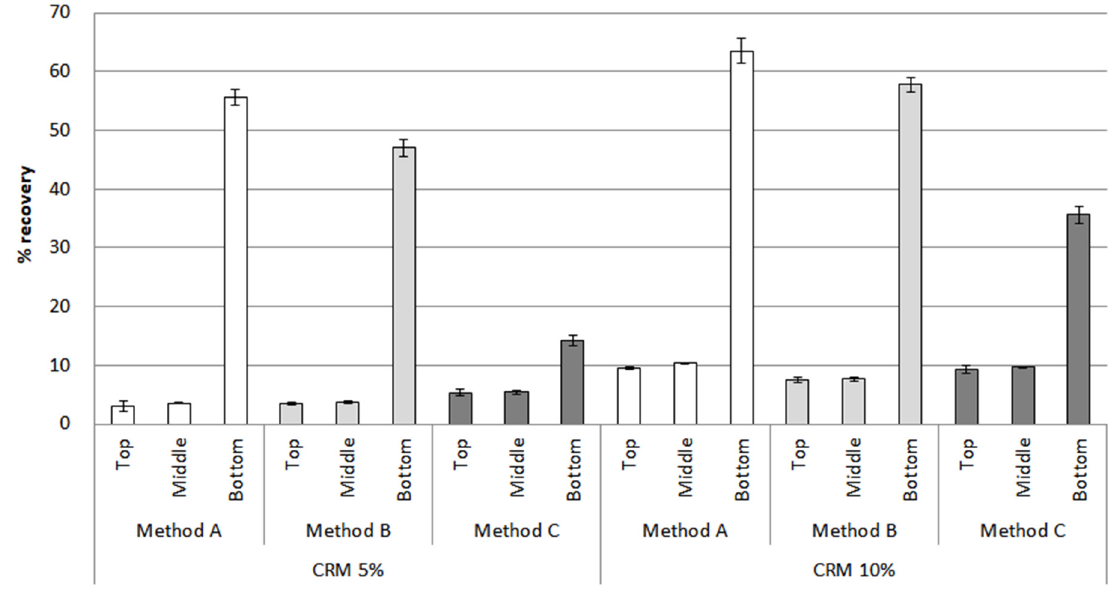
Figure 13. The percentage recovery (0.1 kPa) of the CRM asphalt binders for each mixing method in the top, middle, and bottom parts, after conditioning.